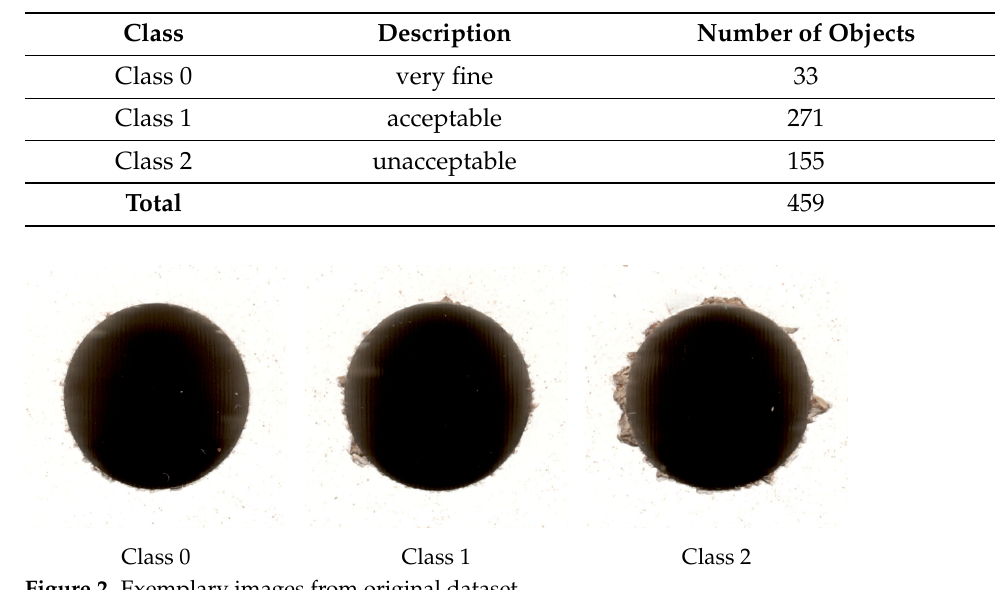
Figure 2. Exemplary images from original dataset.